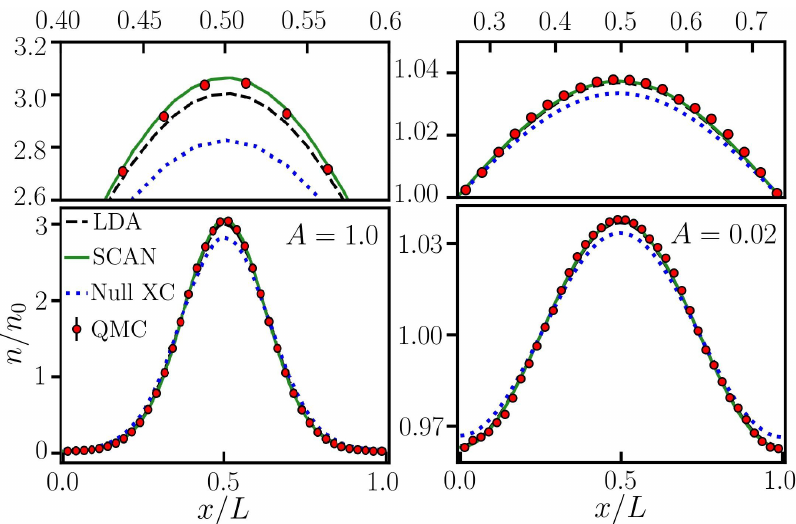
= 2 and θ = 1. QMC s = XC